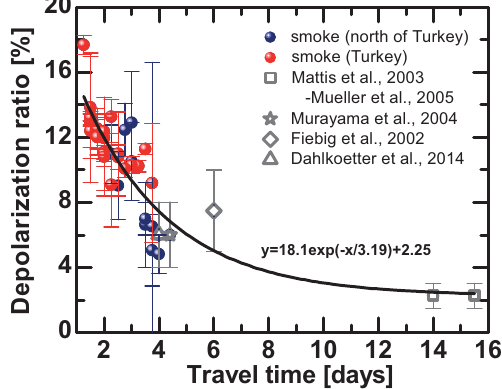
Figure 9. Decrease of the layer-mean particle linear depolarization ratio of smoke-influenced aerosol layers with increasing travel time, defined as the temporal distance between Limassol and the last fire area which the observed air masses crossed before arriving at Li- massol. Ten of the 21 blue circles (cases without Turkish smoke) were influenced by smoke generated in areas north of the Black Sea. The exponential fit indicates a 1/e decay time (dust decrease) of 4 days. Grey symbols show observations as published in the given literature. Vertical bars show the range of observed depolarization ratios (literature values) or show the standard deviation of the values determined within the individual layers (red and blue